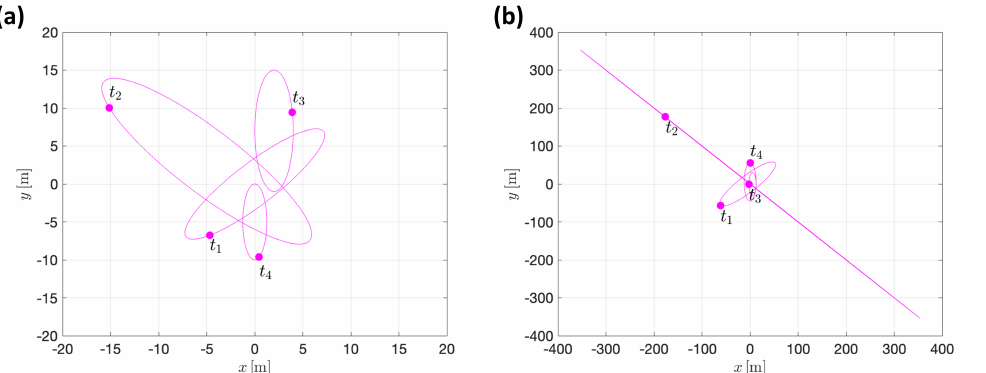
Figure 12. ( a ) Simulated target trajectories for Experiment 1. ( b ) Corresponding target trajectories for Experiment